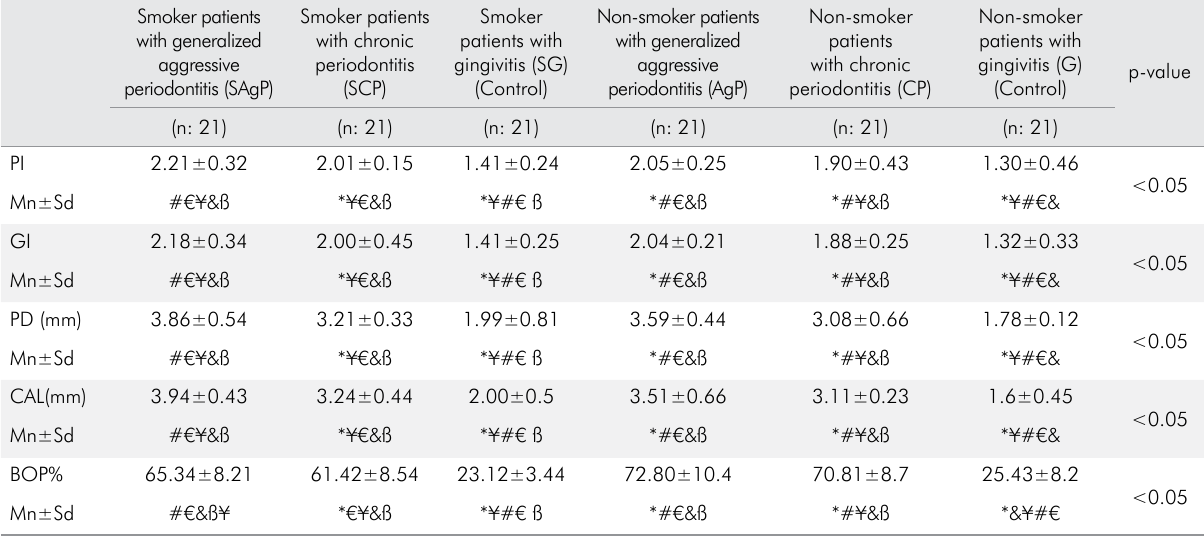
Table 2. Clinical Periodontal Measurements (Site Specific) of the Study Groups (Mean±Standard deviation). Smoker patients with generalized aggressive periodontitis